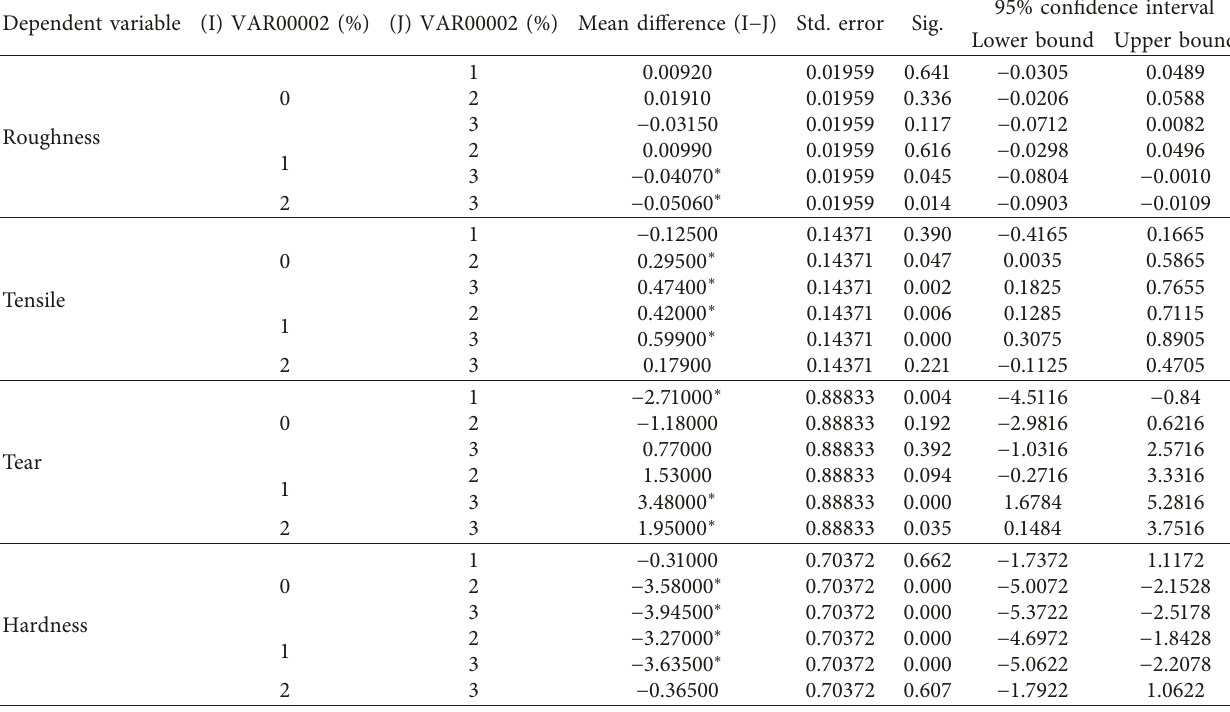
Table 3: Post hoc test showing significant difference between all tested